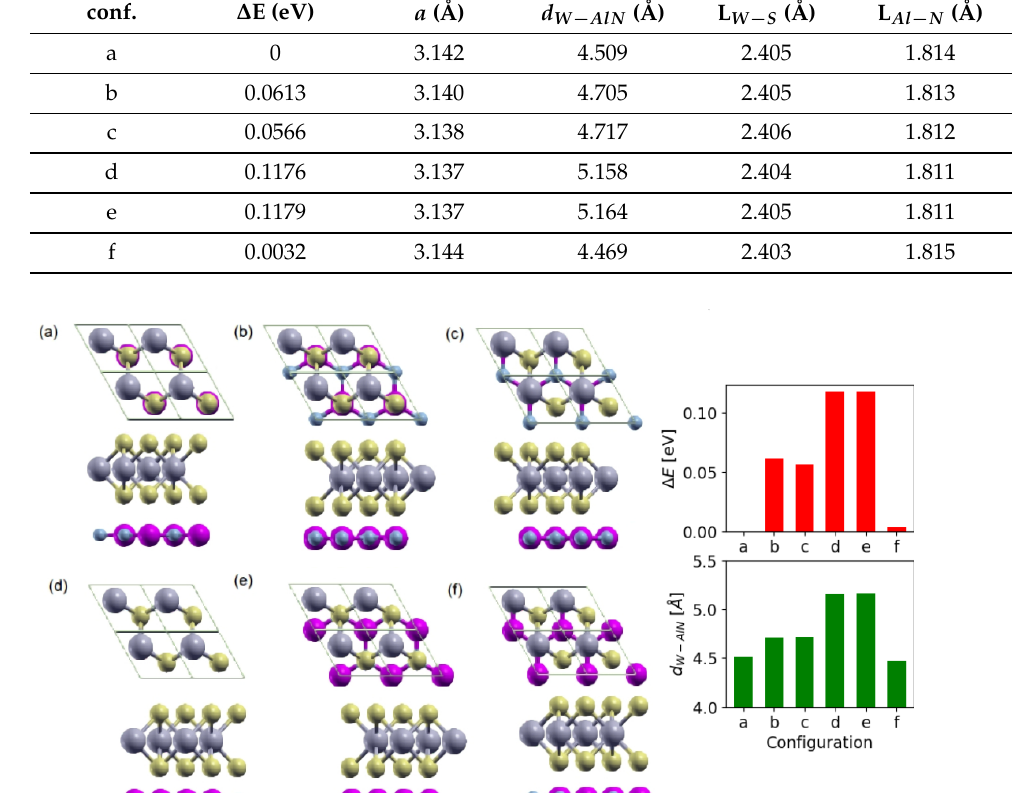
Table 1. Energy difference ∆ E (eV), layer distance d W − AlN , L W − S and L Al − N bond lengths of the different configurations of AlN / WS 2 heterostructures calculated by DFT-PBEsol including vdW correction. Notice that for the L W − S distance, we consider the S atom towards the AlN layer. conf.